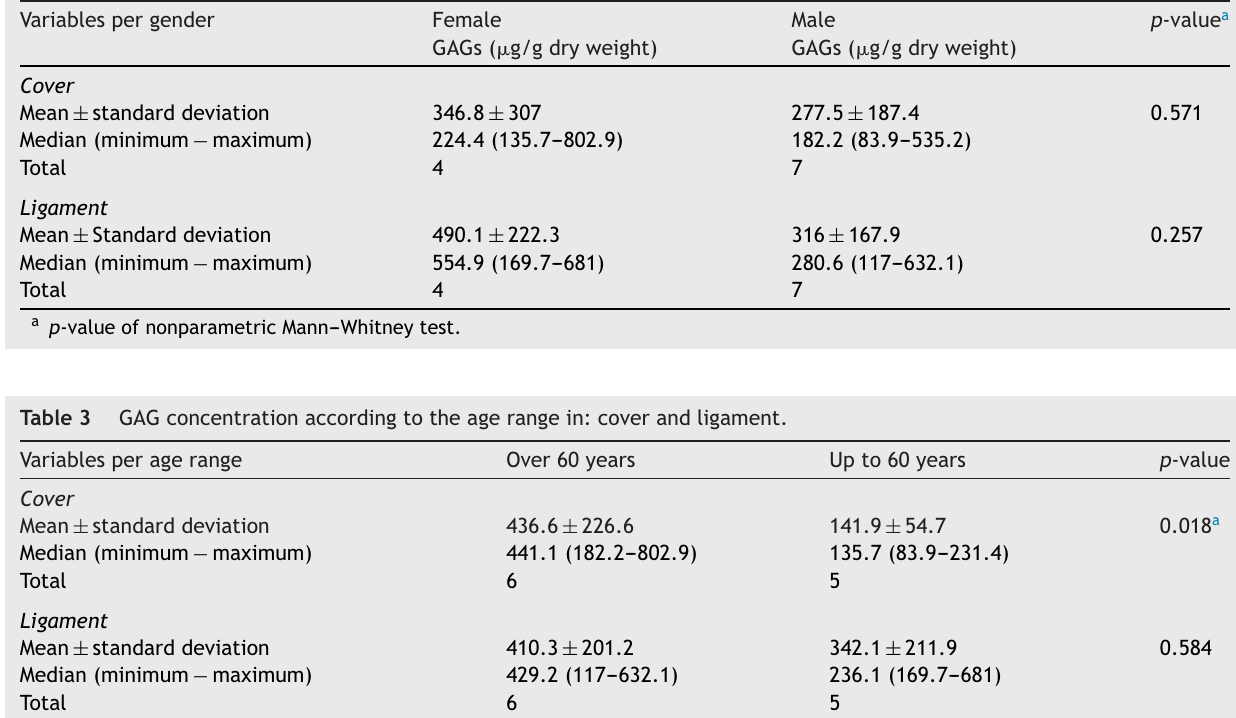
GAG concentration according to gender in the cover and ligament.